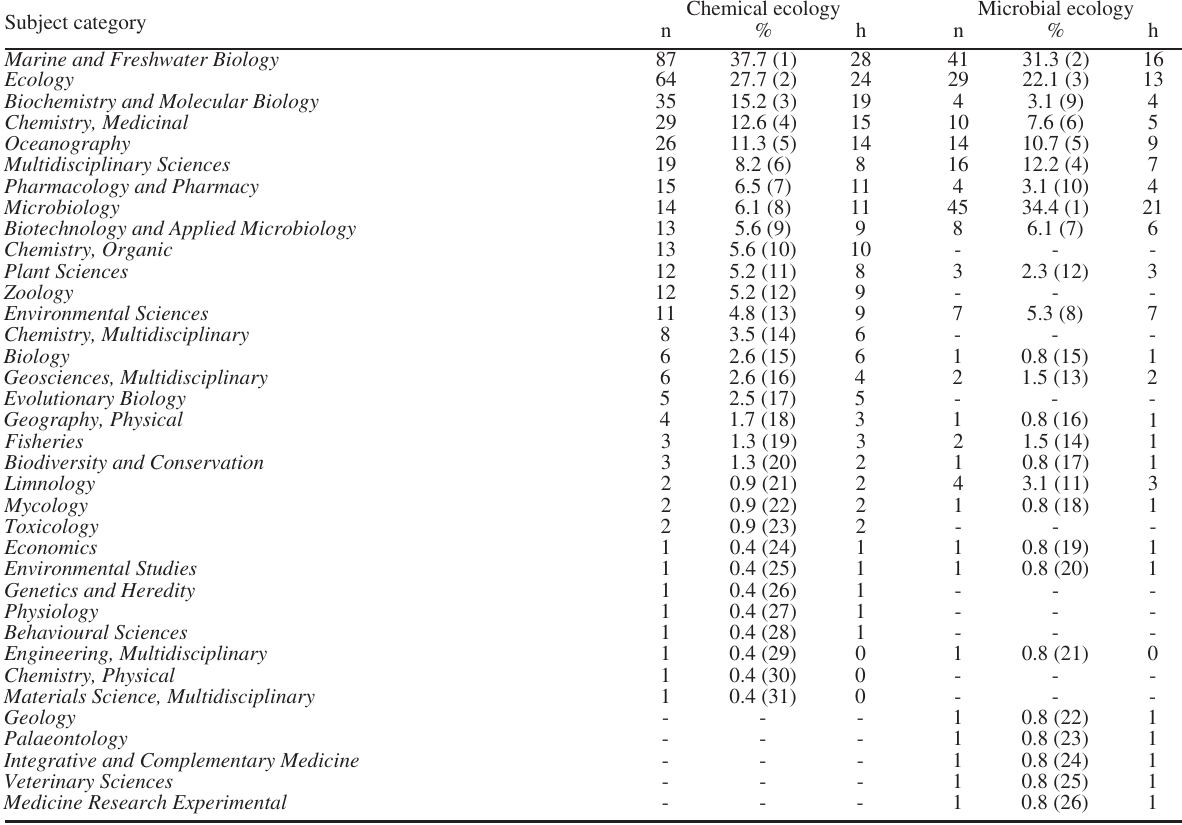
 , where n denotes the number of papers of the research field, c i denotes the number of citations of the i th publication, and e denotes the average number of citations of all papers in the year in which the i th publication appeared. i Table 2. – Number of papers (n), percentage of total papers on sponge chemical and microbial ecology (%), and h - index for each subject category. Ranking for each subject category within brackets; ‛ -’ no records